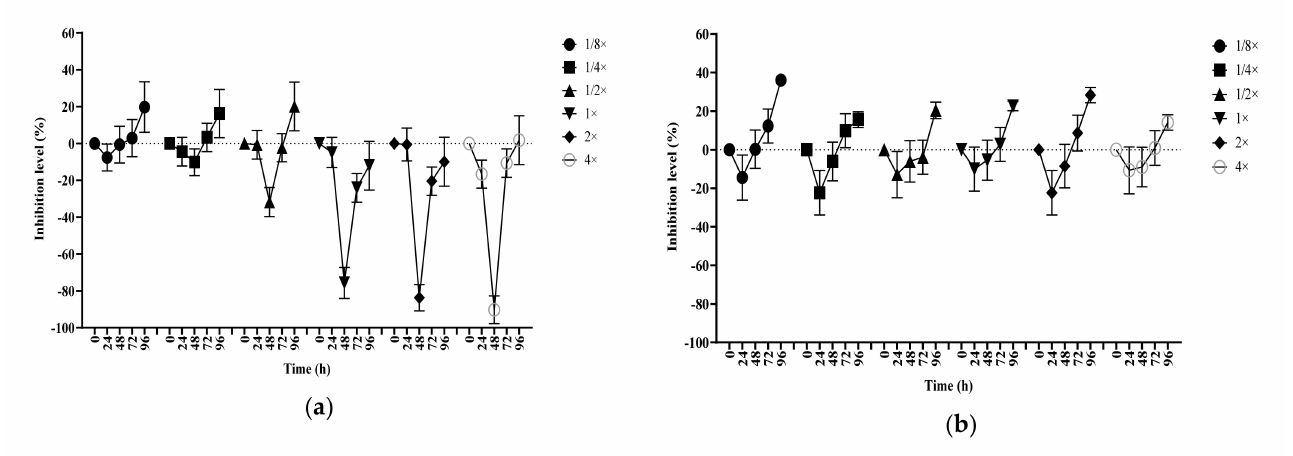
Figure 1. C. vulgaris index effect by the exposure to 4 different pharmaceuticals. ( a ) Atenolol; ( b ) Caffeine; ( c ) Carbamazepine; ( d ) Ibuprofen. See Table 1 for explanation of drug concentration linked to the sample number.